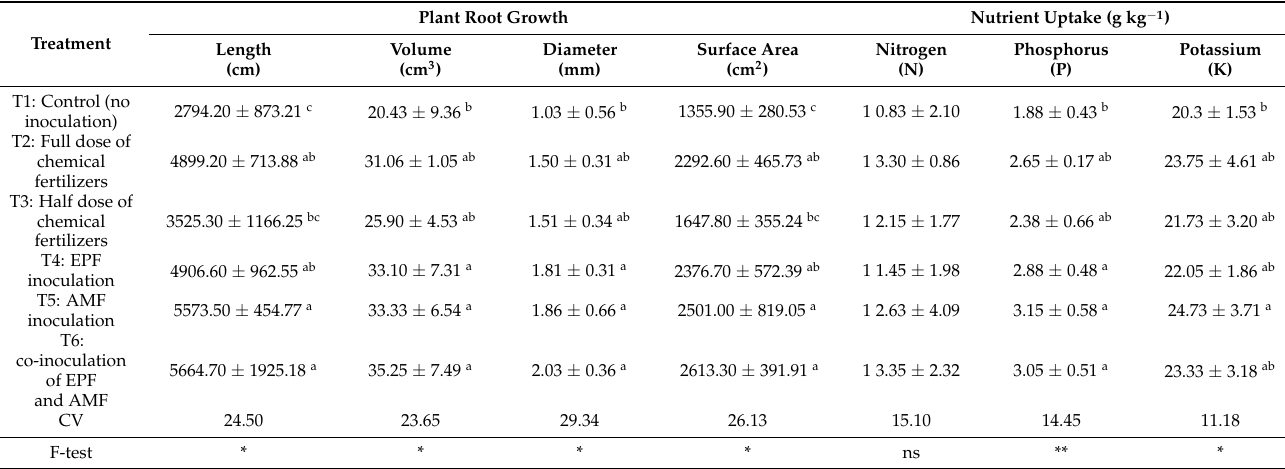
Table 3. Plant root growth parameters including length, volume, diameter, surface area, and nutrient uptake of sunchoke at 90 days after planting under field conditions.